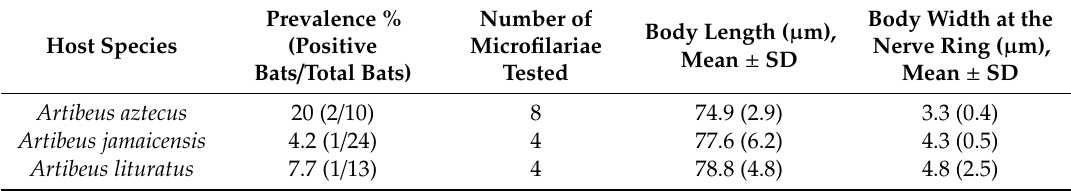
Figure 1. ( A ) Blood smear. Sheathed microfilaria of Litomosoides sp. ( B ) Pulmonary arterial vessel. The black arrow indicates smooth-muscle hypertrophy. ( C ) Exudative pneumonia with an inflammatory infiltrate composed predominantly of neutrophils, the tissue also displayed congestion. ( D ) Spleen. Moderate lymphoid depletion and mild lymphoid hyperplasia. Table 1. Microfilariae morphometric per bat host species.